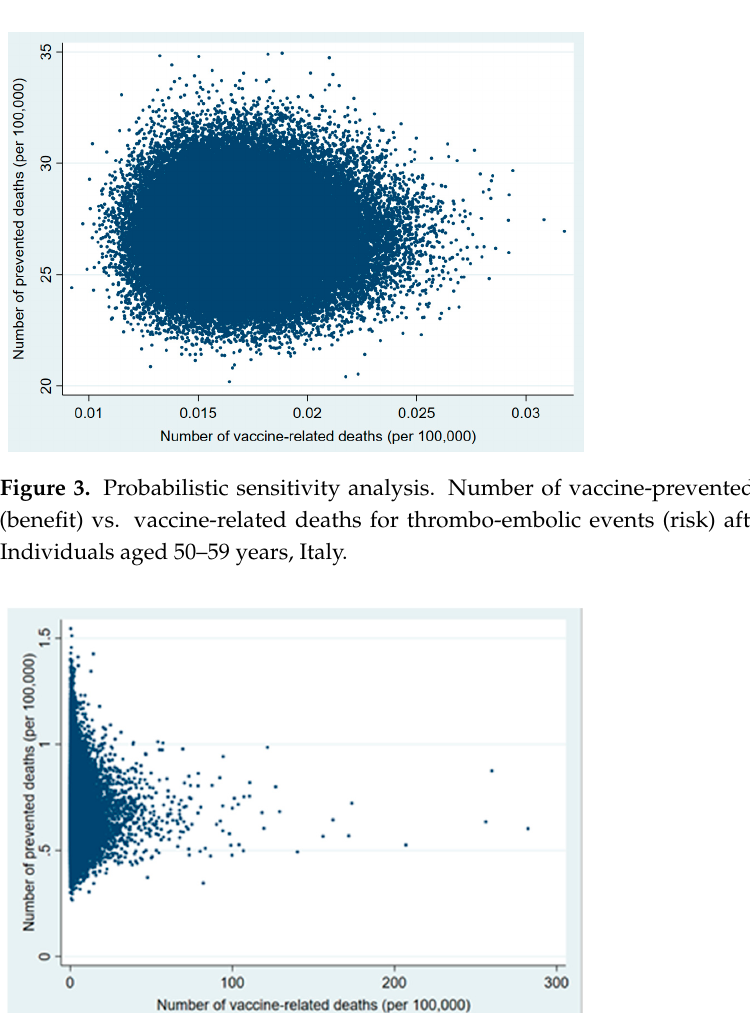
Figure 4. Probabilistic sensitivity analysis. Number of vaccine-prevented deaths for COVID-19 (benefit) vs. vaccine-related deaths for disseminated intravascular coagulation and cerebral venous sinus thrombosis (risk) after 100,000 simulations. Individuals aged 20–29 years, Italy.